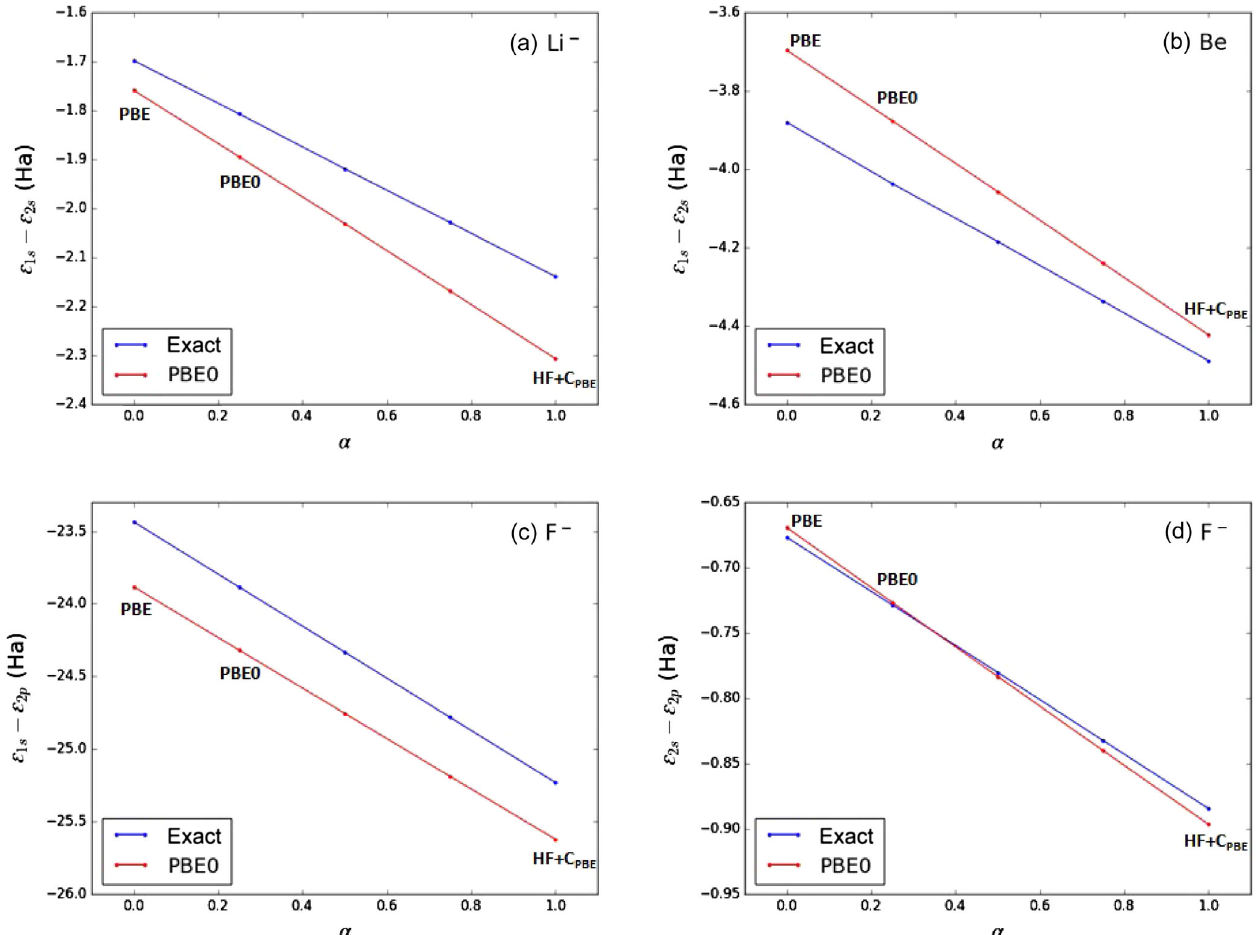
FIG. 6. Difference of orbital energy from that of the highest occupied orbital, from exact and PBE 0 α GKS maps, as a function of α . (a) Li − 1 s , (b) Be 1 s , (c) F − 1 s , (d) F − 2 s